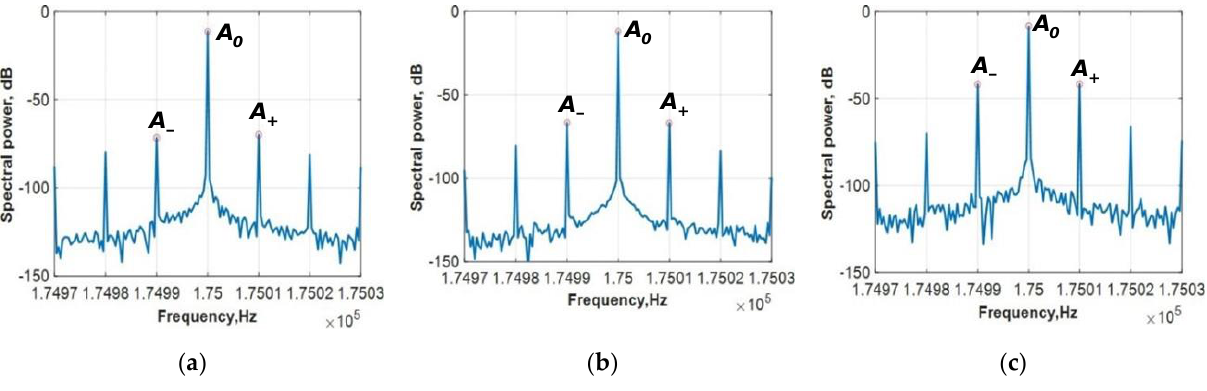
Figure 2. Spectra in the frequency window of 60 Hz around the probe frequency f = 175 kHz for Sample #3: ( a ) after 11,252 load cycles, no damage initiation; ( b ) after 47,139 cycles, initial damage accumulation; ( c ) after 51,219 cycles, visible crack. The number of cycles to failure was 52,106 (see Table 2). Table 2. The number of cycles to failure for the six tested samples.